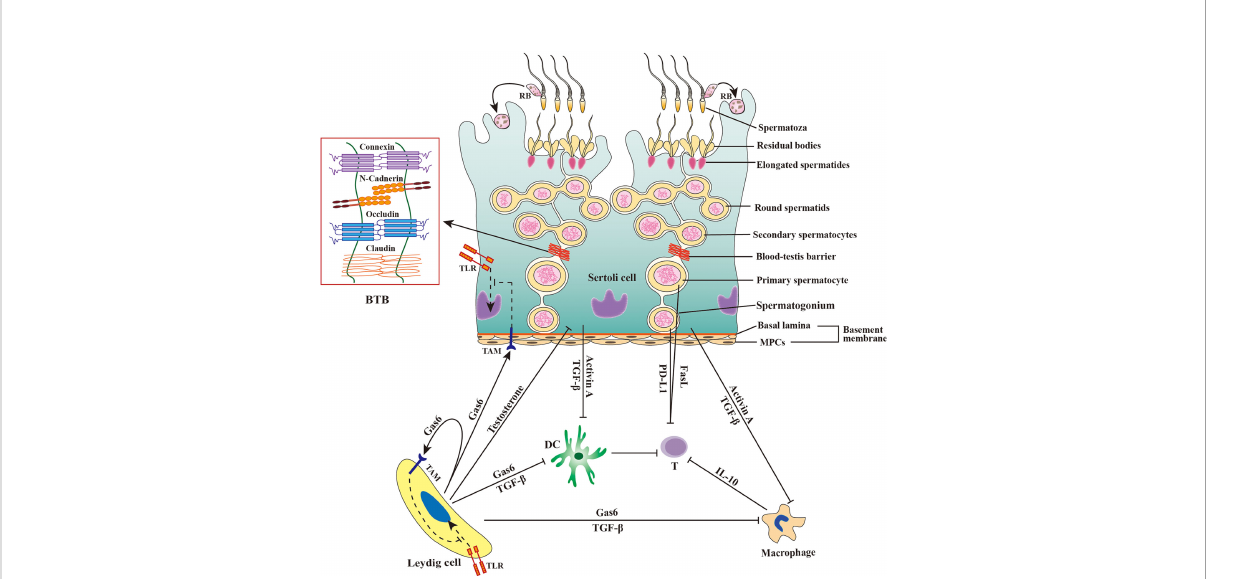
FIGURE 1 Schematic of immune privilege in the testis. The immune privilege of the testis is regulated by the tissue structure and anti-in fl ammatory factors. The blood-testis barrier (BTB) separates the late stage of germ cells from immune cells in the interstitial spaces. Sertoli cells secrete activin A and transforming growth factor b (TGF- b ) that inhibit the immune responses of dendritic cells (DCs) and macrophages. Leydig cells produce growth-arrest-speci fi c gene 6 (Gas6), TGF- b , and testosterone, which inhibit the immune responses of DCs, macrophages, and Sertoli cells. Male germ cells produce Fas ligand (FasL) and programmed death-ligand 1 (PD-L1), and both FasL and PD-L1 induce apoptosis of T lymphocytes (T). Macrophages exhibit immunosuppressive properties by producing anti-in fl ammatory cytokine IL-10 to inhibit effective T lymphocyte responses. Sertoli cells and Leydig cells express Tyro3, Axl and Mer (TAM) receptor tyrosine kinases, which can be activated by Gas6 and inhibit toll-like receptor (TLR)-initiated innate immune responses. MPCs, myoid peritubular cells; RB, residual body; ⟂ ,